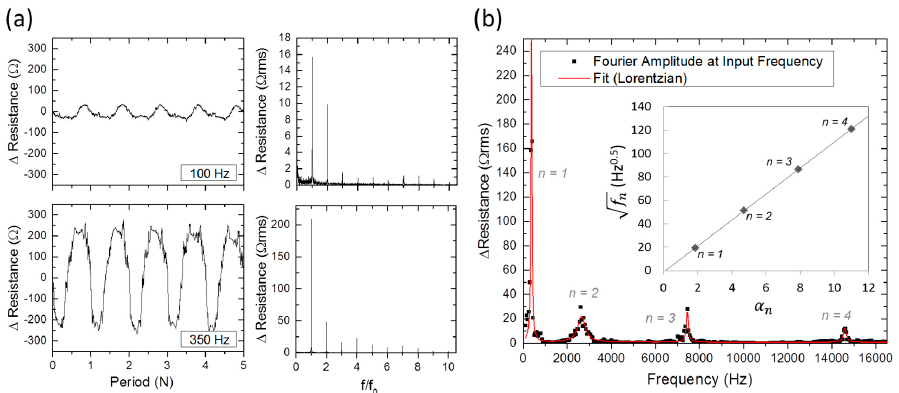
Figure 1. The response of Sensor 1 with L E = 4.00 mm to dynamically modulated air flow: ( a ) The change in resistance at 100 Hz and 350 Hz over five periods and the corresponding Fourier transformed frequency response scaled by the input frequency ( f 0 ). ( b ) The amplitude of the Fourier transformed response at the input frequency versus the input frequency. The peaks correspond to the first four resonance modes ( n ) of the hair sensor. (Inset) The square root of the resonance frequencies ( f n ) versus the amplitude factors of the fixed-free Euler-Bernoulli beam with a linear fit. To investigate the relationship between the vibrational response of the sensors and their exposed hair length, a second sensor (Sensor 2) was incrementally reduced from an initial L E of 4.73 mm to a final L E of 0.83 mm. This sensor was one of 25 sensors previously examined in steady flow conditions [4]. The magnitude of the Fourier transformed response is plotted versus the frequency in Figure 2a for each length. Up to five resonance peaks are visible at the initial hair length and progressively shift to higher frequencies as L E is reduced as expected. The peaks corresponding to the primary mode can be fit to the expression for a damped oscillator with a small damping coefficient (e.g., 0.008 for L E of 2.78 mm). The resonance frequencies were extracted and are plotted versus the exposed length in Figure 2b.